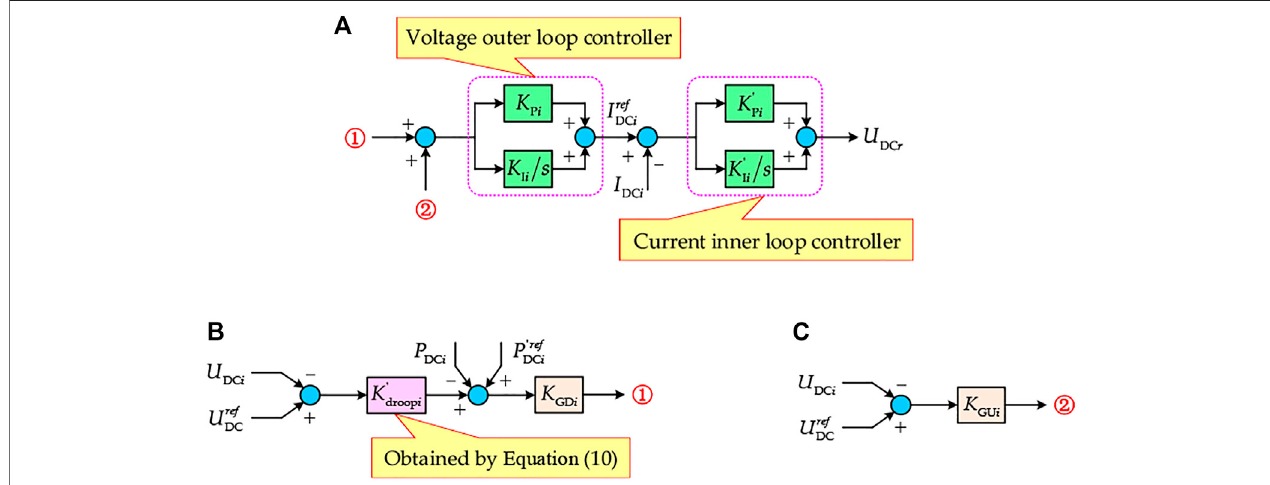
FIGURE 4 | Block diagram of the control strategy: (A) voltage and current double closed loop control; (B) power deviation control; (C) additional DC voltage deviation control.